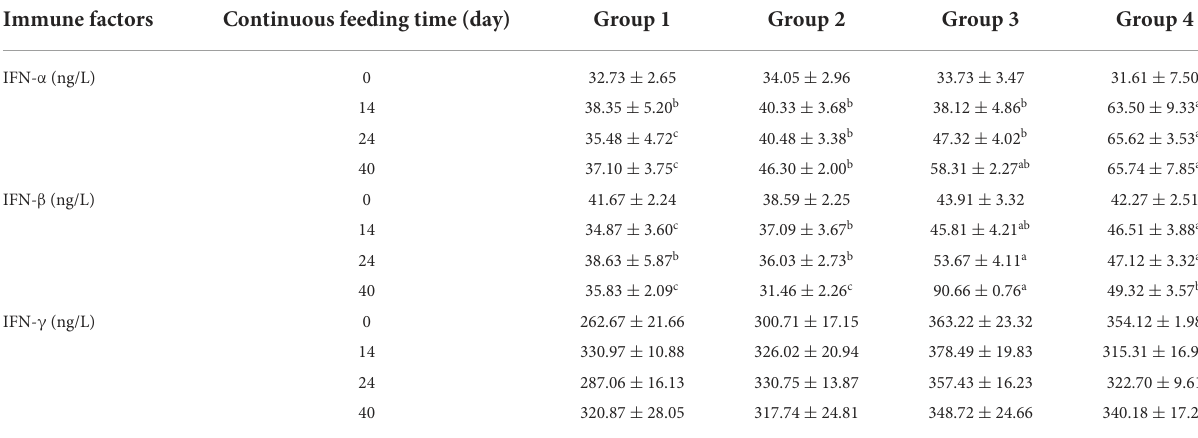
TABLE 8 Comparison of serum interferons levels (mean ± SD) among four treatment groups ( n = 5 in each group). Immune